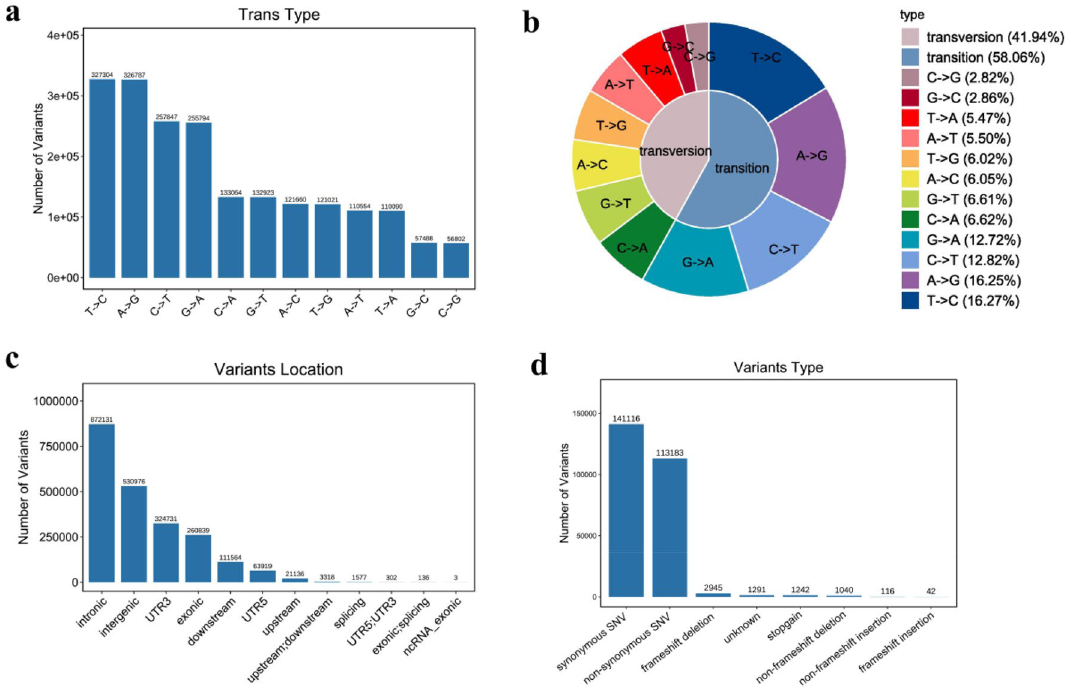
Figure 10. The type, location and function distributions of SNP. ( a , b ) Number and proportion of each type of SNP. ( c ) Location distribition of SNP. ( d ) Function classification of